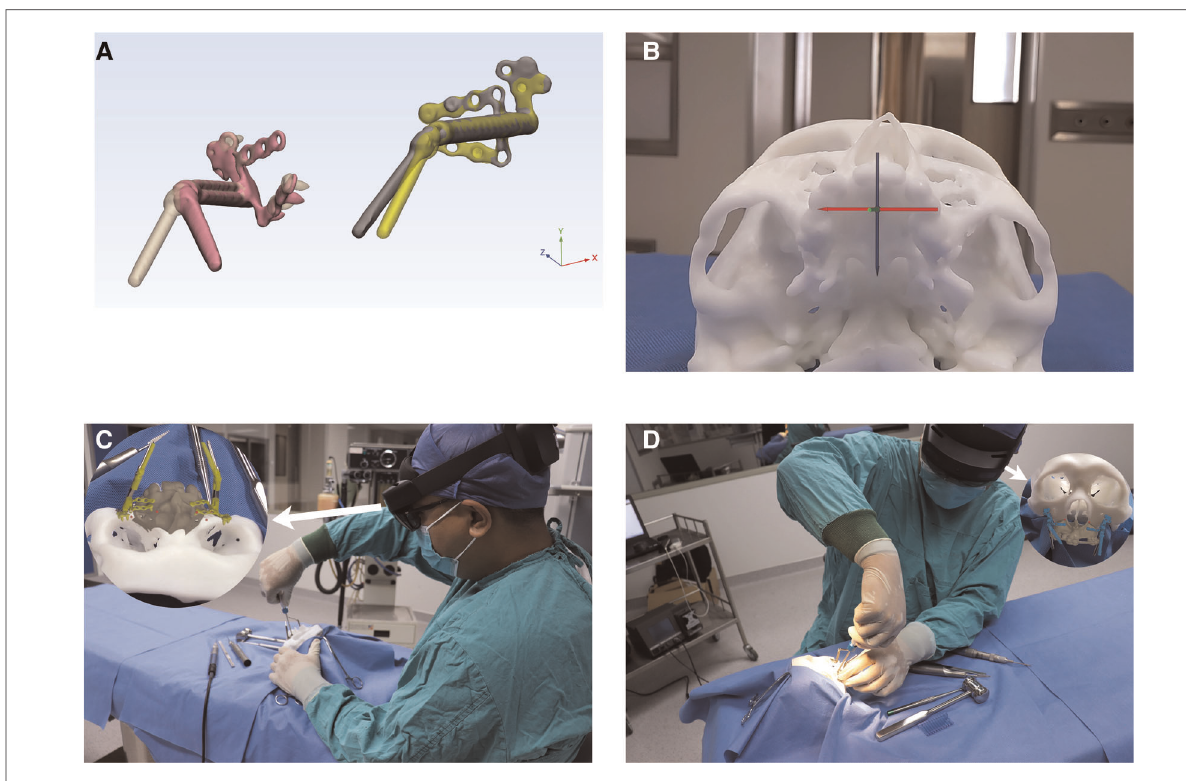
FIGURE 4 Experimental surgery note: ( A ) distractor shape checking after completing the Pre-bending group task, the 3D models of the actual distractors (opaque) overlapped with the pre-operative plan (translucent), indicating no deformation of the distractor occurred in the Pre-bending group task. ( B ) Automatic calibration can be achieved by the surgeon moving his head and aiming the cruci fi x at the dentition (Microsoft Hololens 2 view). ( C ) The surgeon checked the detractor vector in the patient ’ s cephalic position. ( D ) The surgeon could accomplish the check in the patient ’ s lateral